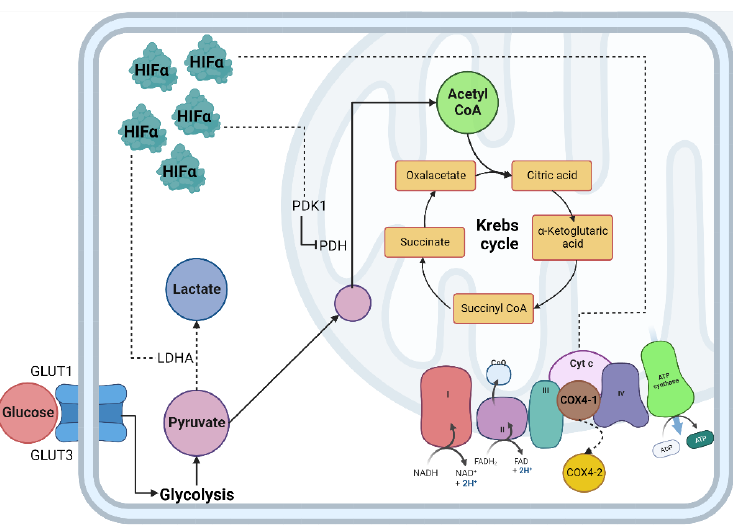
Figure 1. Cellular adaptation to hypoxia. The primary method of obtaining energy is the oxidation of glucose; under normoxic conditions, this begins in the cytosol through glycolysis, followed by the decarboxylation of pyruvate, then the TCA cycle where NADH and FADH2 are obtained, which, by giving up their electrons to the chain transport electrons, create an electrochemical proton gradient in the mitochondrial intermembrane and allow ATP synthase to release ATP molecules. In hypoxia, the enzymes involved in the glycolytic pathway, such as PDH, are inhibited by PDK1, decreasing the production of acetyl-CoA and increasing the production of lactate due to the activity of the enzyme LDH. Abbreviations: TCA: Tricarboxylic acid; NADH: reduced nicotinamide adenine dinucleotide; FADH2: reduced flavin adenine dinucleotide; ATP: adenosine- 5’ -triphosphate; PDH: pyruvate dehydrogenase; LDH: lactate dehydrogenase; HIF- α: Hypoxia Inducible Factor α subunit; HIF- β: Hypoxia Inducible Factor β subunit; Dotted line: HIF - α mitochondria l target gene.